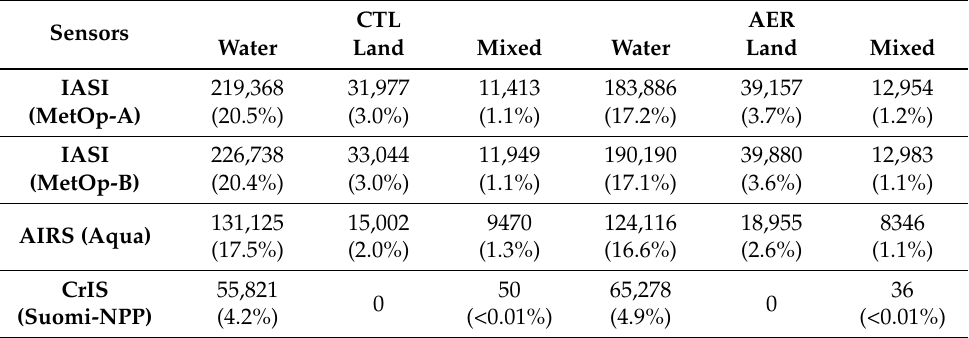
Table 4. Comparison of the count of assimilated observations over different surface type at 10.39 µm of IASI on MetOp-A and -B, CrIS onboard Suomi-NPP, and 10.36 µm of AIRS onboard Aqua for period 1–28 August 2017 in CTL and AER. The percentage of the total amount of each sensor is indicated in the